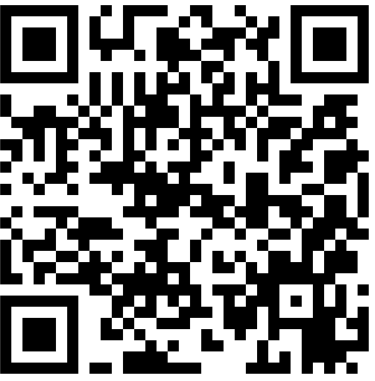
Figure 2. Fiducial marker.